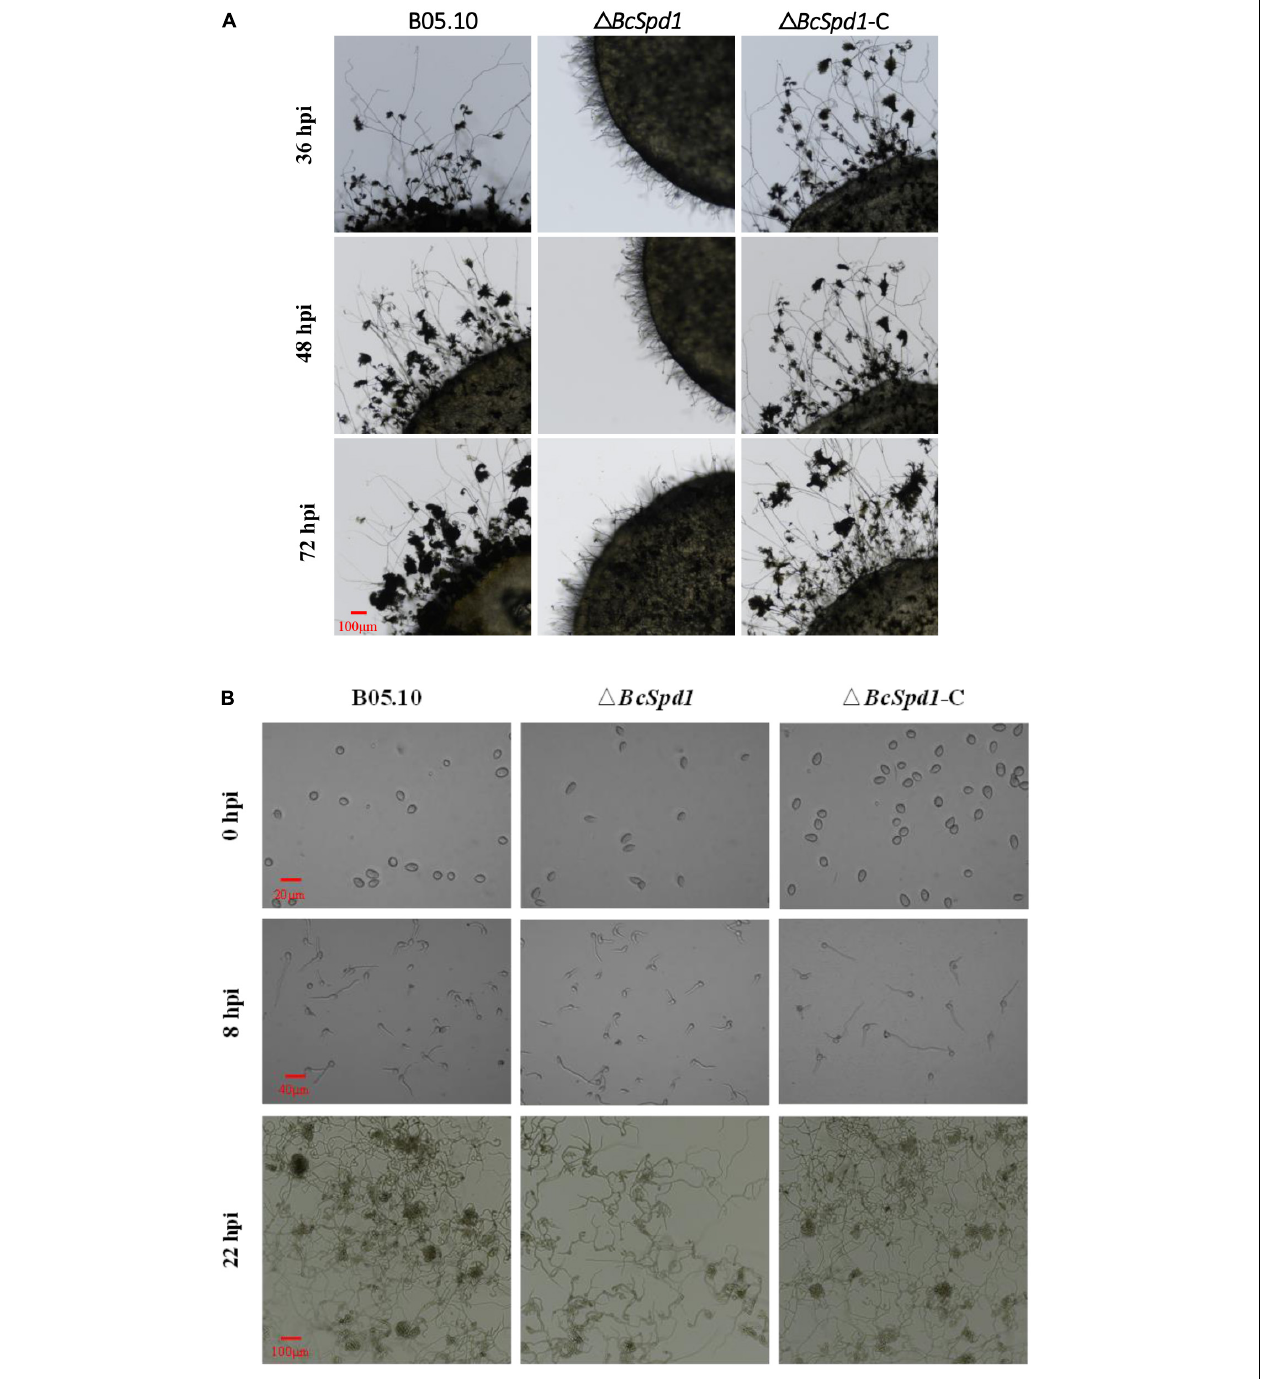
FIGURE 3 | Impact of BcSpd1 deletion on infection cushion formation. (A) Mycelial plugs of wild-type strain B05.10, (cid:49) BcSpd1 , and the complemented strain (cid:49) BcSpd1- C were incubated on a hydrophobic glass. The photos were taken at 36, 48, and 72 h, respectively. (B) Formation of infection cushion when fungal spores were incubated on the hydrophobic glass. Photos were taken at 0, 8, and 22 h, respectively.